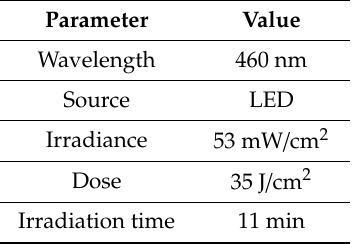
Table 1. Main characteristics of blue light irradiation.